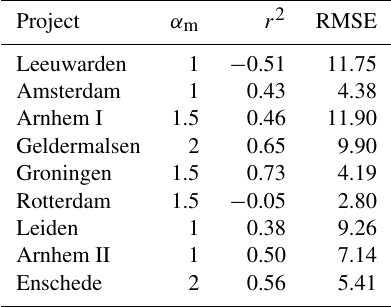
Table 1. Results of the project by project analysis.